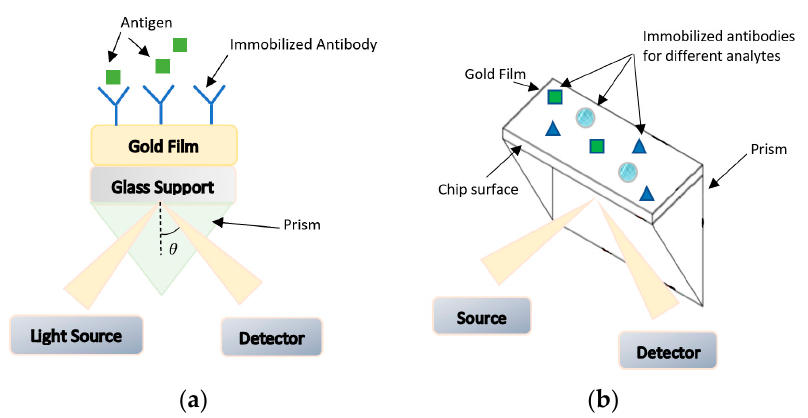
Figure 9. ( a ) Working principle of surface plasmon resonance (SPR) biosensors. ( b ) Working principle of SPR biosensors chip.